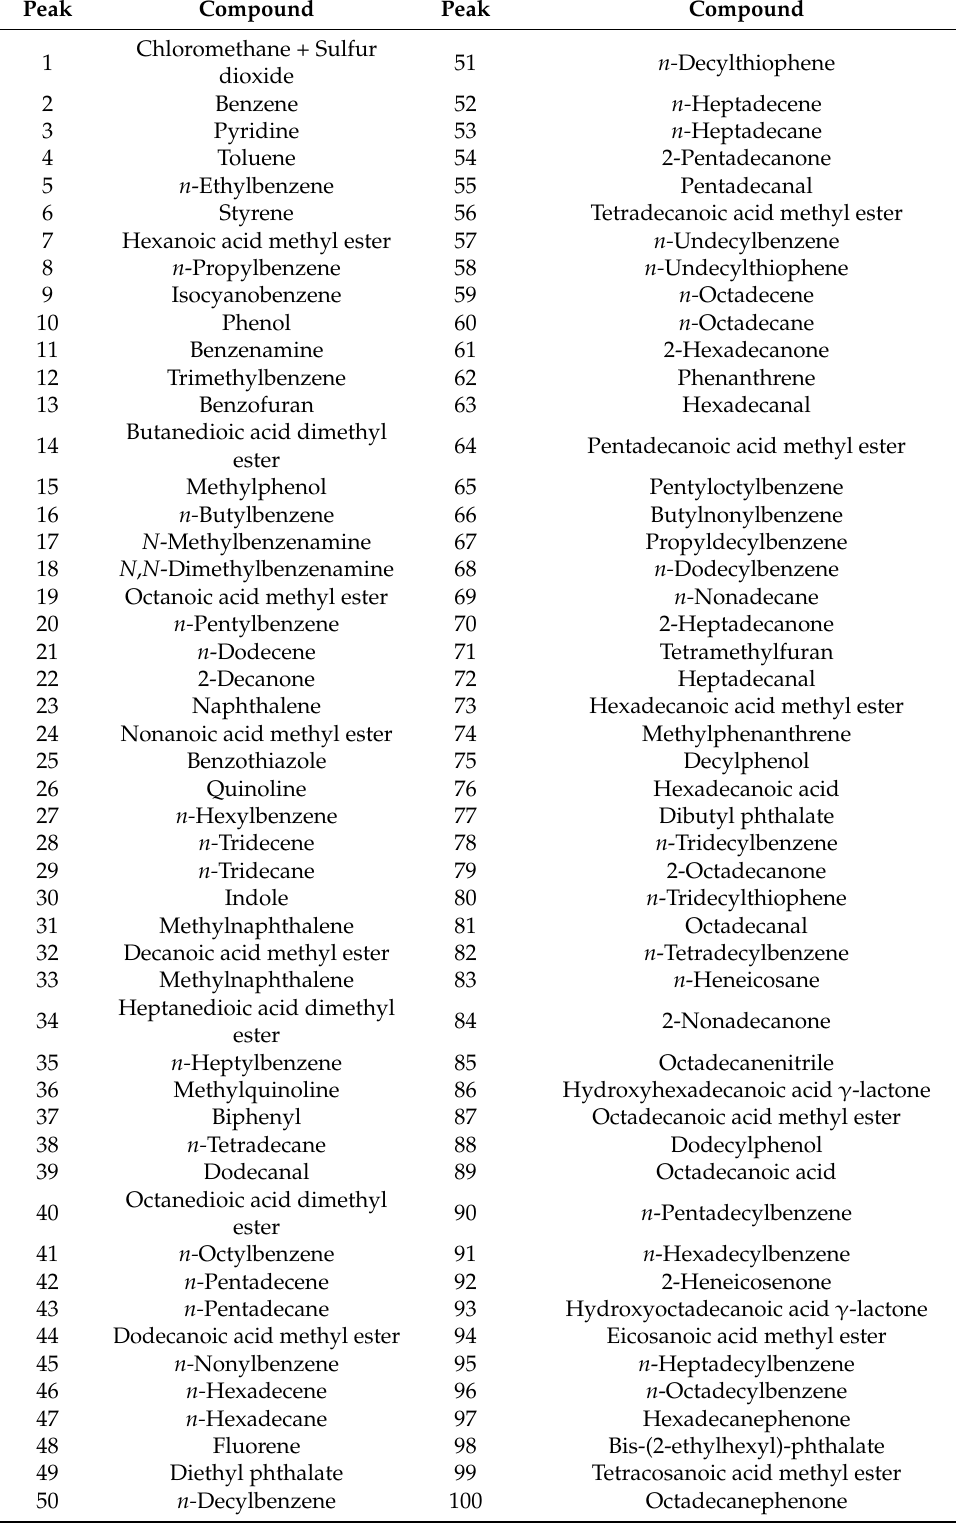
Table 4. Pyrolysis products obtained in the pyrolysis at 250 and 400 ◦ C (double shot) with tetramethyl ammonium hydroxide of the acid hydrolyzed Ochroconis lascauxensis